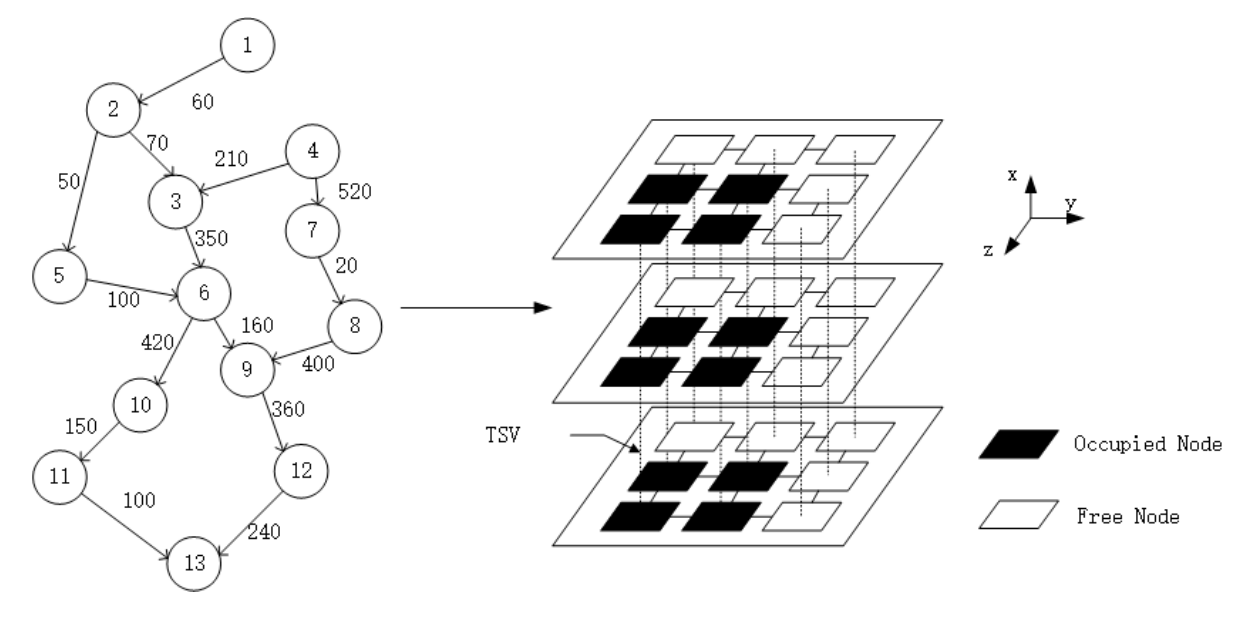
Figure 2. Example map of region division.